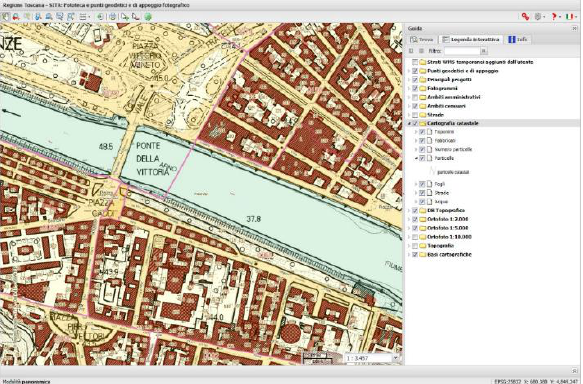
Figure 10. Geoscope layout.